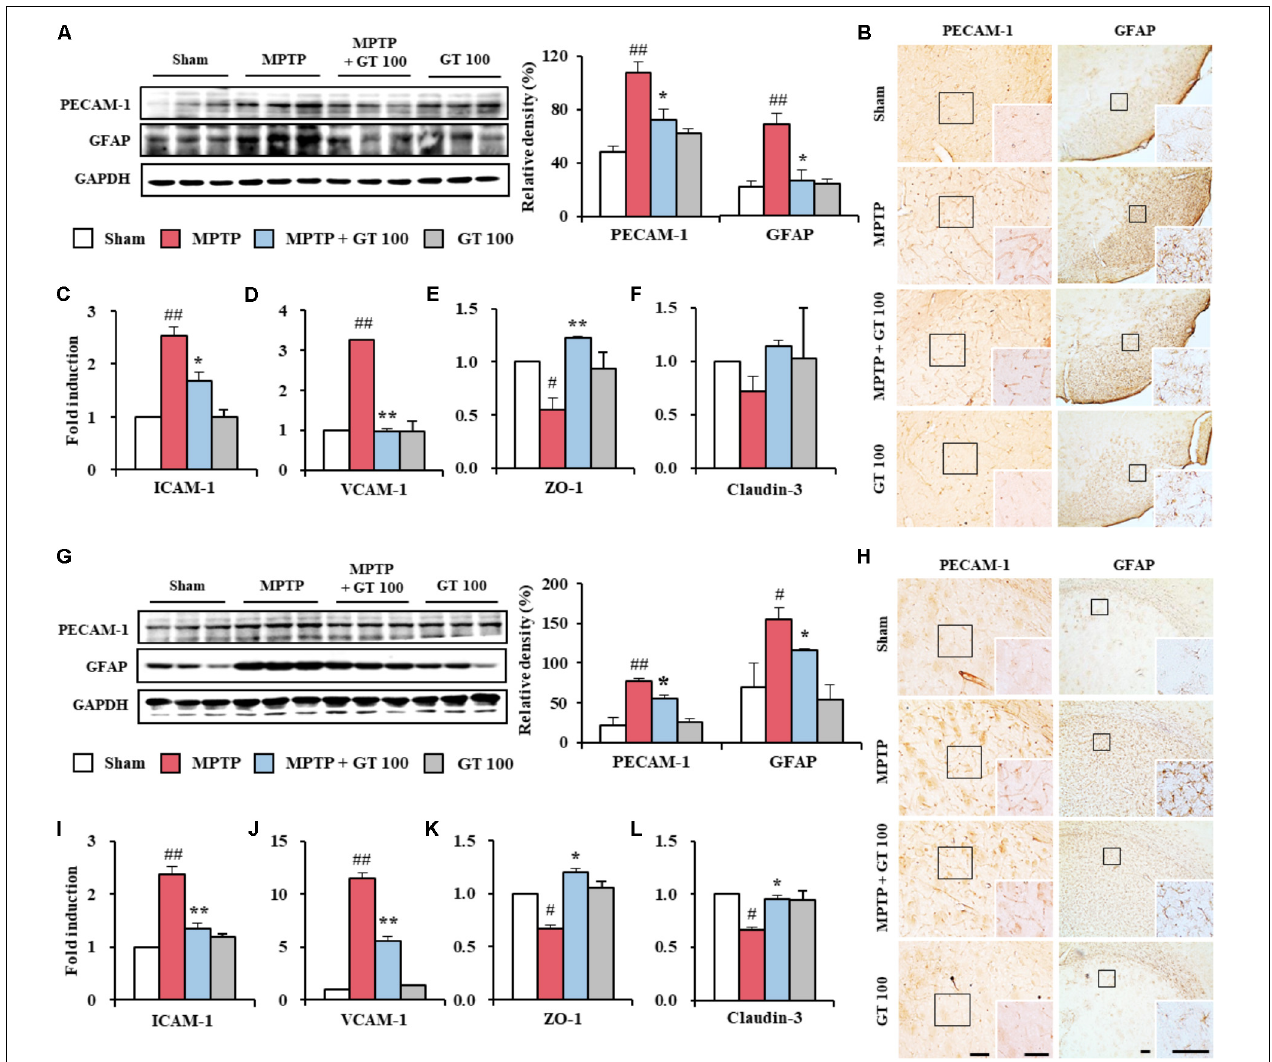
FIGURE 5 | Gintonin prevents disruption of the BBB integrity in the SNpc and striatum after MPTP injection. (A,G) SNpc and striatum sample ( n = 3 per group) were quantified by immunoblot analysis using PECAM-1 and GFAP antisera. The left panels illustrate representative Western blots. (B,H) SNpc and striatum sections ( n = 3 per brain) from each group ( n = 5 per group) 7 days after MPTP-injection were immunostained using PECAM-1 and GFAP antisera. Insets display high magnification micrographs of the areas marked with squares. Scale bar = 50 µ m. (C–F,I–L) Real-time PCR using primers for ICAM-1 (C,I) , VCAM-1 (D,J) , ZO-1 (E,K) , and claudin-3 (F,L) was used to quantify the expression of these molecules in SNpc (C–F) and striatum (I–L) ( n = 3 per group) 7 days after MPTP-injection. ANOVA test; # p < 0.05 and ## p < 0.01 vs. Sham group. ∗ p < 0.05 and ∗∗ p < 0.01 vs. MPTP